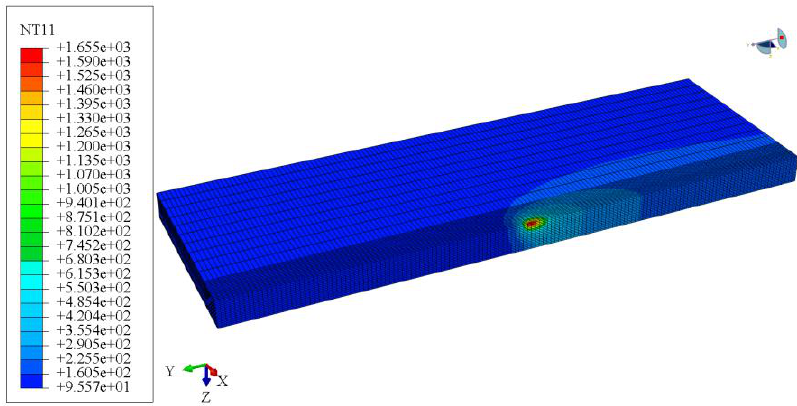
Figure 9. Temperature gradient obtained when the virtual source of heat is in the middle of the first welding pass.